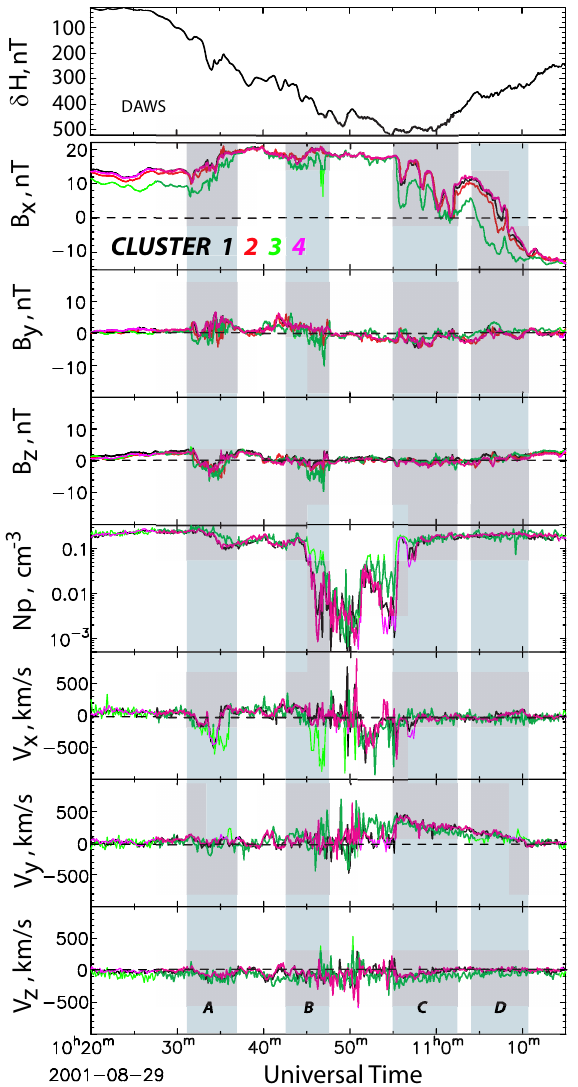
Fig. 3. CANOPUS (Dawson) magnetogram and Cluster/FGM and CIS-CODIF measurements in magnetotail during 10:20–11:15 UT, 29 August 2001. (not shown), located near midnight. The energy of elec- trons, observed by LANL 1991–080, jumps from ∼ 500 eV to ∼ 10 keV at ∼ 10:35 UT and remains at this level until ∼ 11:30 UT.